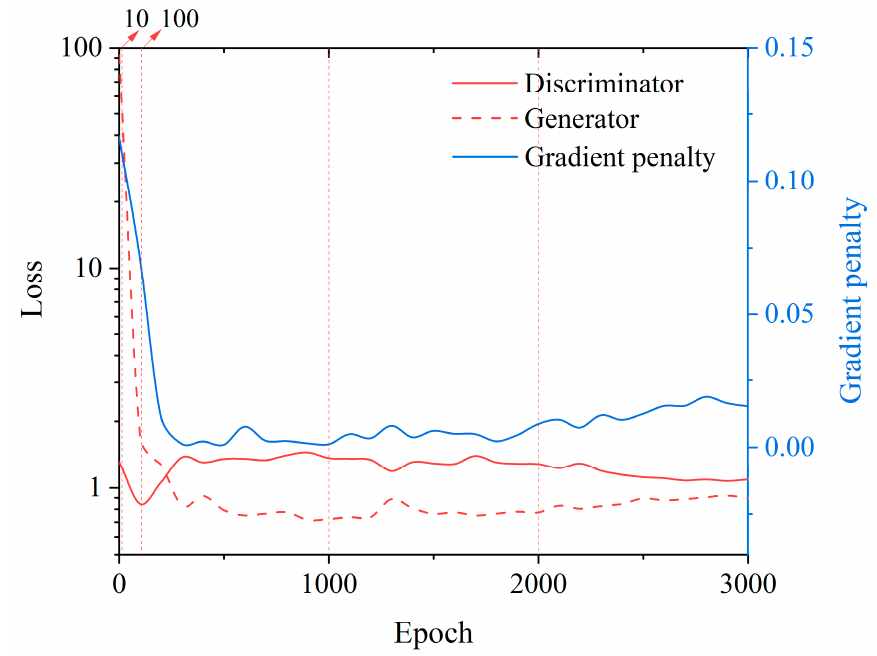
Figure 3. Training loss and gradient penalty for US-WGAN.